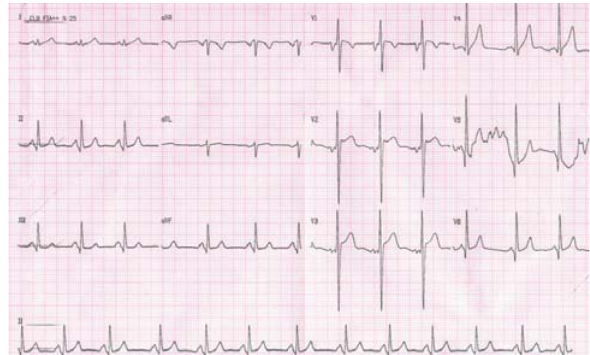
Fig. 1 – Eletrocardiograma em doença valvar mitral